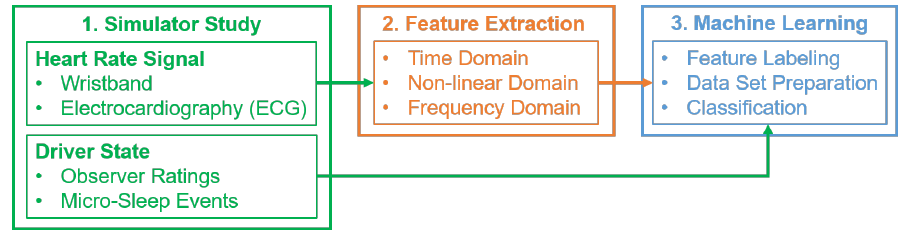
Figure 1. Overview of the methodology for the proposed drowsiness detection system. ECG: Electrocardiography.